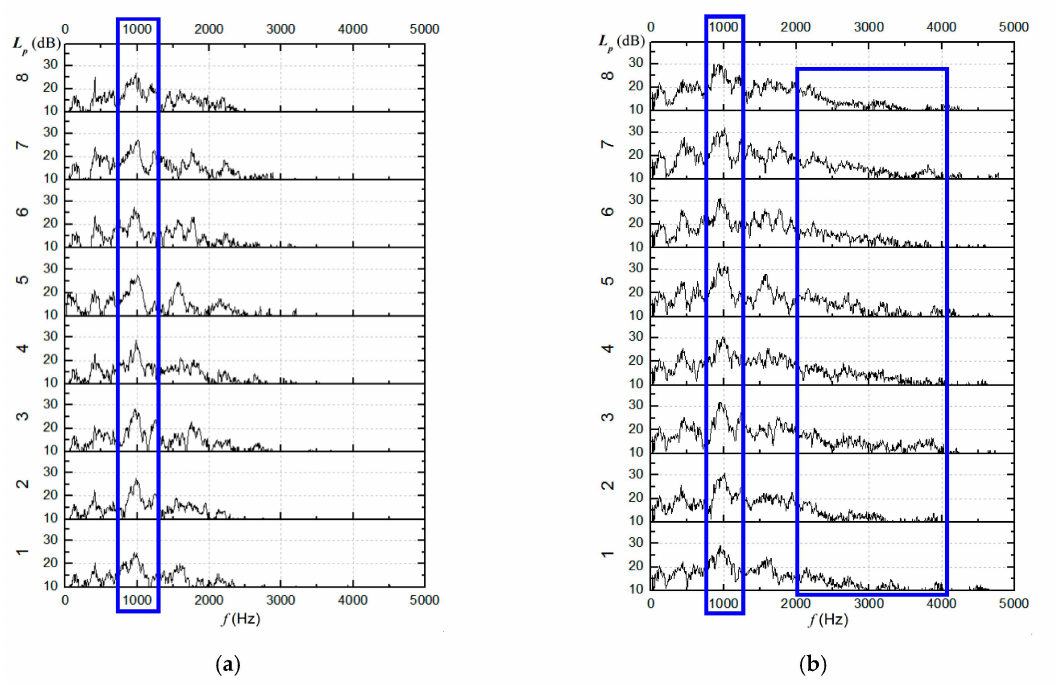
Figure 12. Comparison of the frequency spectra of the B blade model at similar flow rates and different rotating speeds. ( a ) B—0.132 m 3 /s at 1000 rpm, ( b ) B—0.12 m 3 /s at 1300